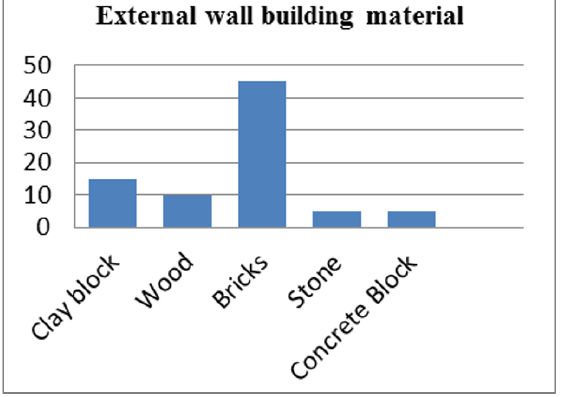
Figure 7. The above bar chart illustrates the external wall building material in the Karakol residential buildings.